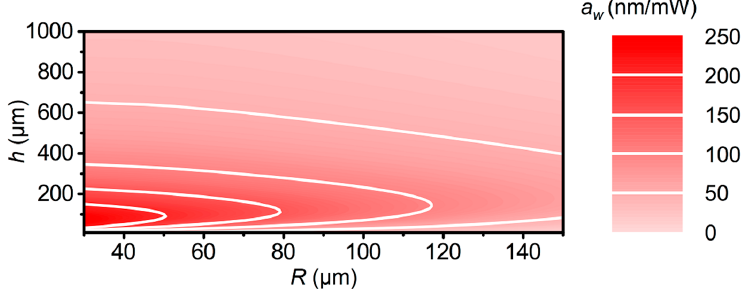
Figure 4. Map of 𝑎 (cid:3050) vs. h and R with p = 150 μ m. In all cases, 𝐶 O,CNT was chosen to be the optimized